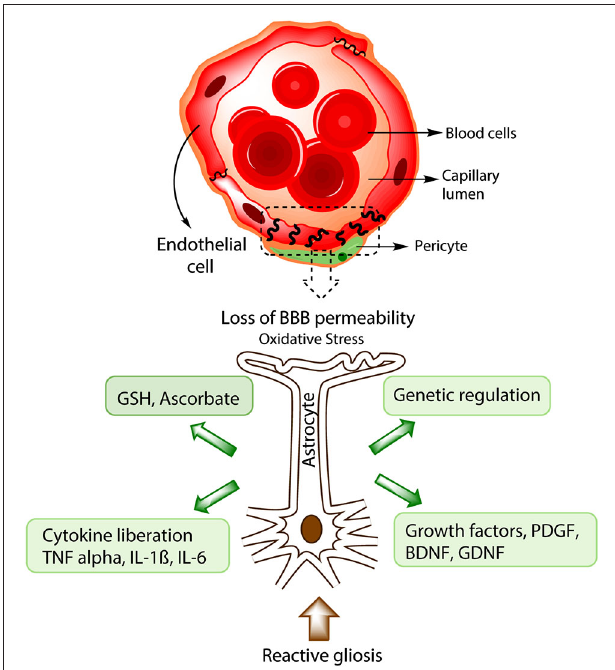
FIGURE 2 | Protective strategies of astrocytes during BBB disruption . In advanced stages of PD, BBB disruption takes place and causes a lost in barrier permeability, entrance of toxic substances and in some instances immune cell infiltration. Processes such as increased ROS production, reactive gliosis and cellular death will inevitably occur. Astrocytic response to BBB disruption includes the production of antioxidative molecules like GSH and ascorbate, generation of growth factors like Brain derived neurotrophic factor (BDNF) and GDNF that could alleviate the cellular death and promote angiogenesis. Furthermore, astrocytes are important in the genetic regulation of endothelial proteins from the tight junction like Occludin and ZO-1. During chronic brain damage, astrocytes also induce the liberation of cytokines like TNF- α , IL-1B, IL-6, important in microglial activation and neuronal